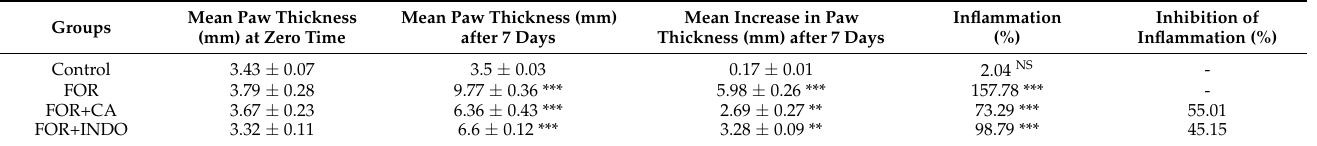
Figure 1. The evolution of paw edema size (mm) in control and treated groups: Control (non-treated rats): received injection with isotonic saline solution (NaCl, 0.9%); FOR: rats inflamed by formalin (2%); FOR+CA and FOR+INDO: rats inflamed by formalin and treated with CA, or indomethacin, respectively. Table 4. The effects of Cleome fruits extract on paw thickness, % of inflammation and inhibition of paw edema in Formalin-induced chronic inflammation in rats.